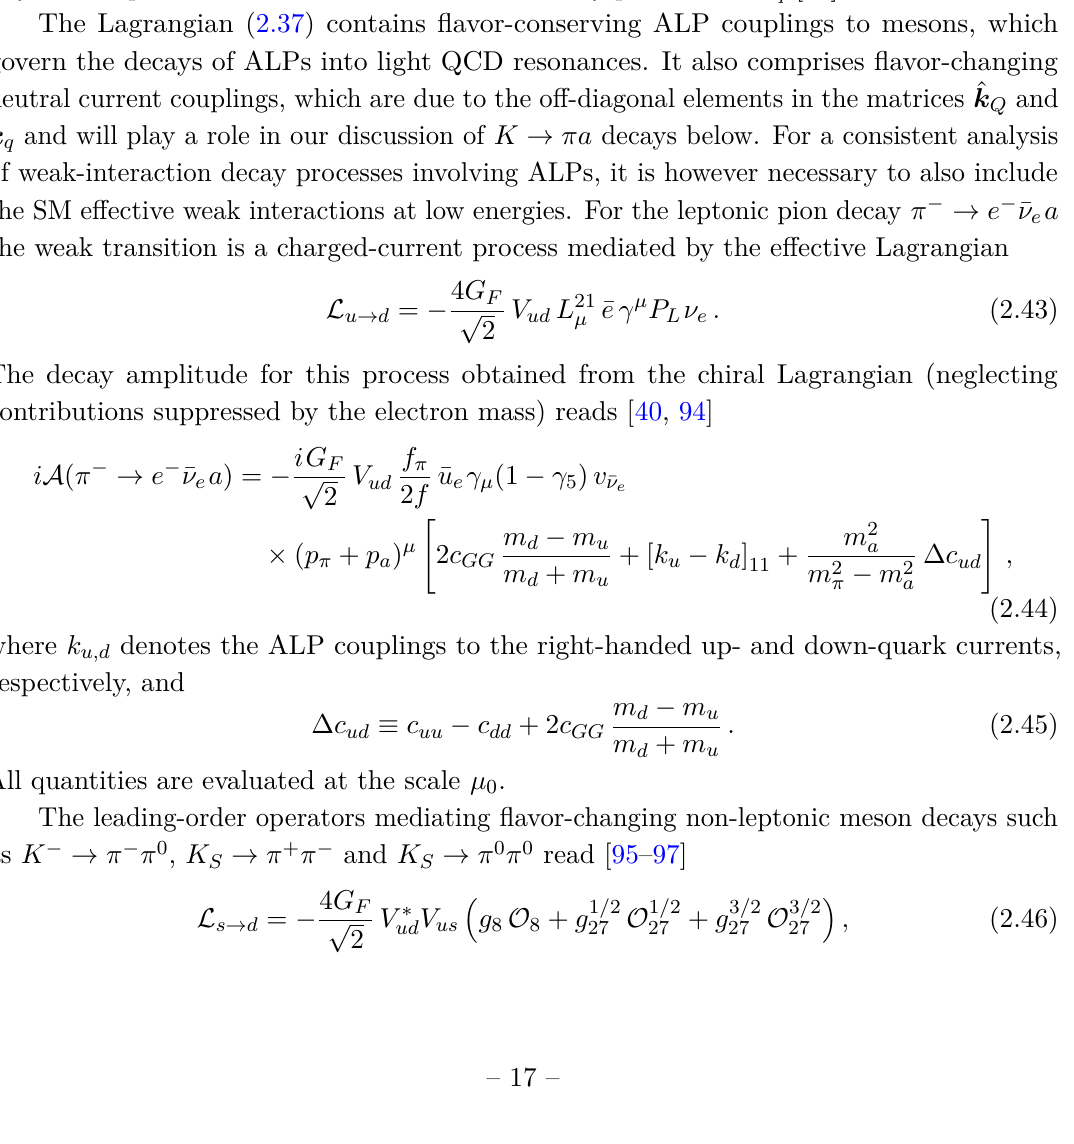
Figure 3 . Feynman graphs contributing to the K − → π − a and at leading order in the chiral expansion. Weak-interaction vertices mediated by the SU(3) octet operator O are indicated by a crossed circle, while dots refer to vertices from the Lagrangian (2.37). 8 Analogous graphs exist for the two 27-plet operators. The first two diagrams in the second row vanish for the case of neutral